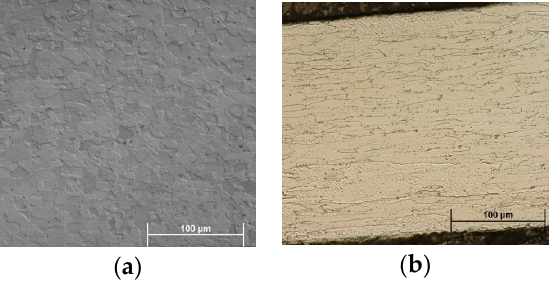
Figure 4. Structure of the experimental materials: ( a ) simply rolled sheet; ( b ) double reduced sheet. Table 1. The chemical composition of the experimental materials expressed in wt %.